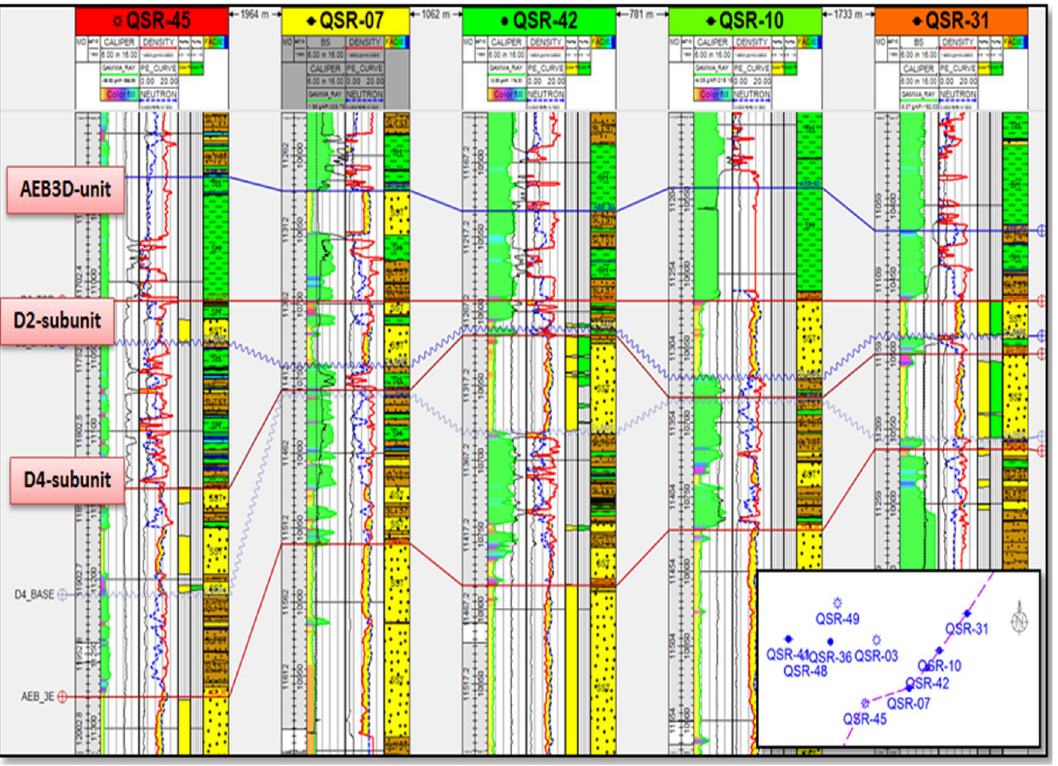
Fig. 4 NE–SW stratigraphic correlation along wells Qasr-31–10–42–07–45. The datum is D2-subunit top. Lithology is shown by colors (yellow for sandstone, green for shale, brown for siltstone, and blue for